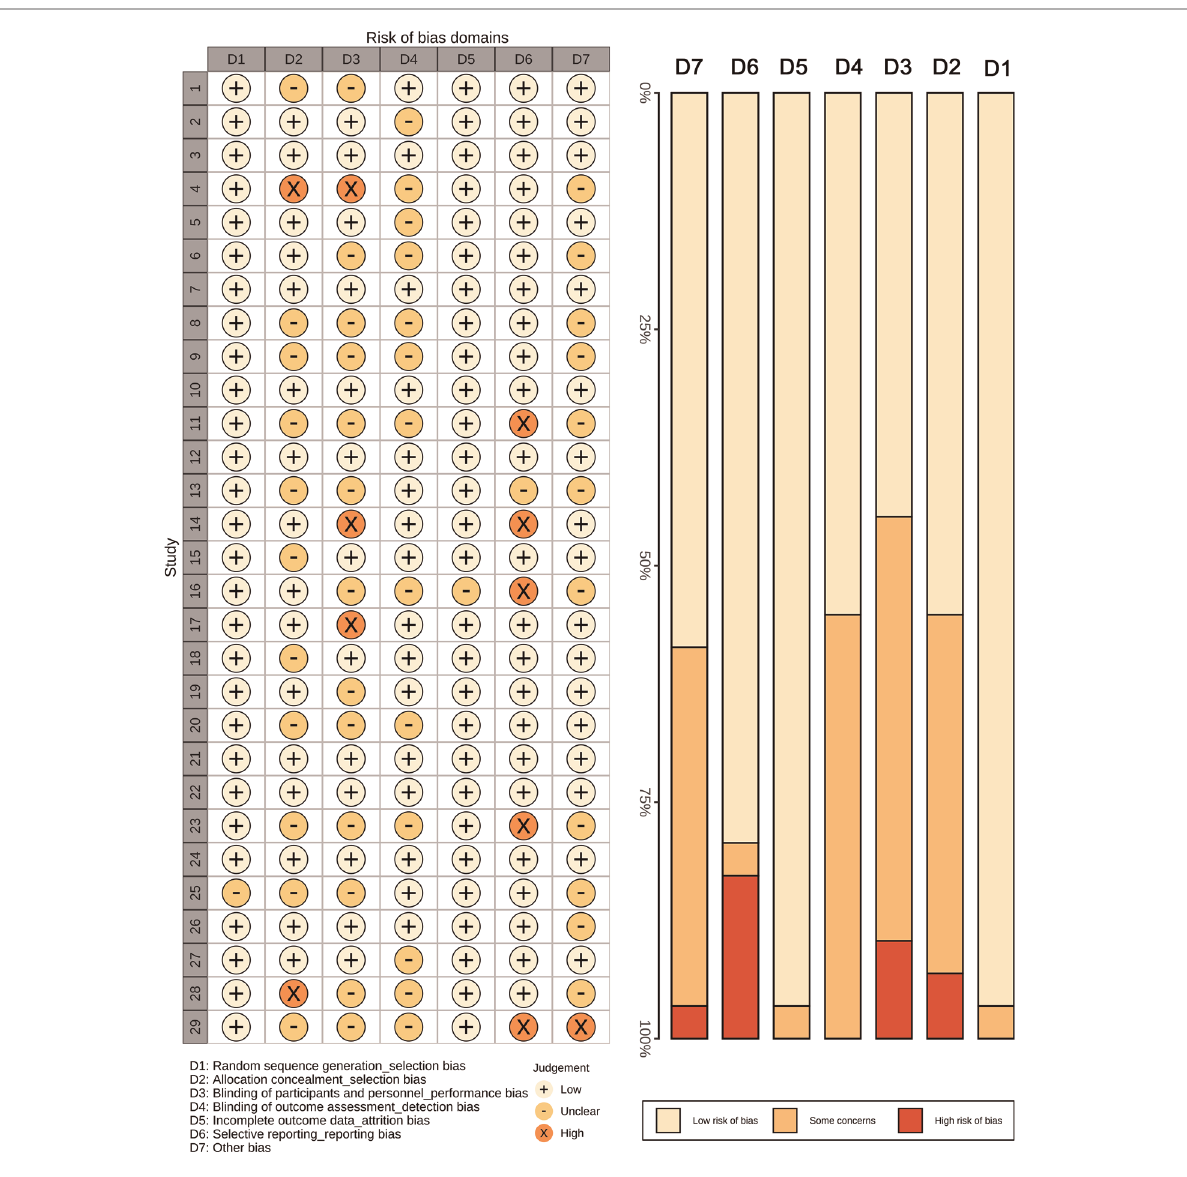
FIGURE 2 The risk of bias summary plot and bar chart for risk of bias assessment. A total of seven domains were assessed. A few studies have high risk of bias concerning the allocation concealment, blinding of participants, selective report, and other